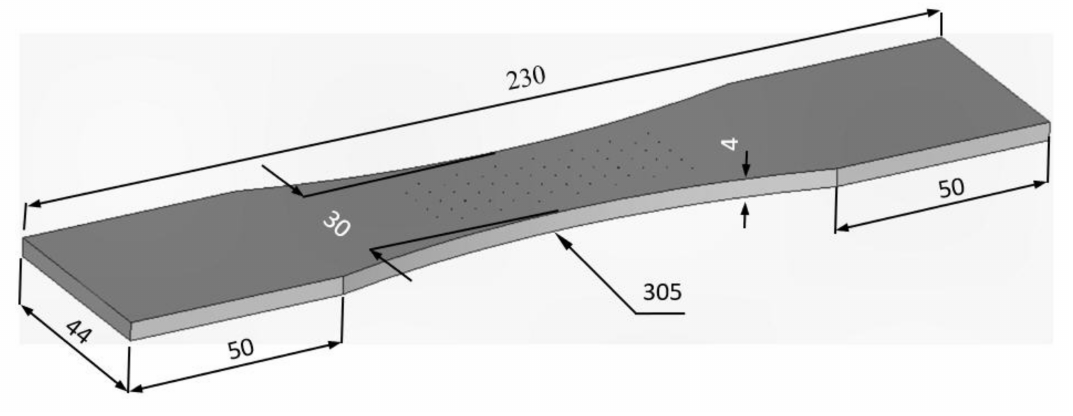
Figure 3. Specimen geometry.